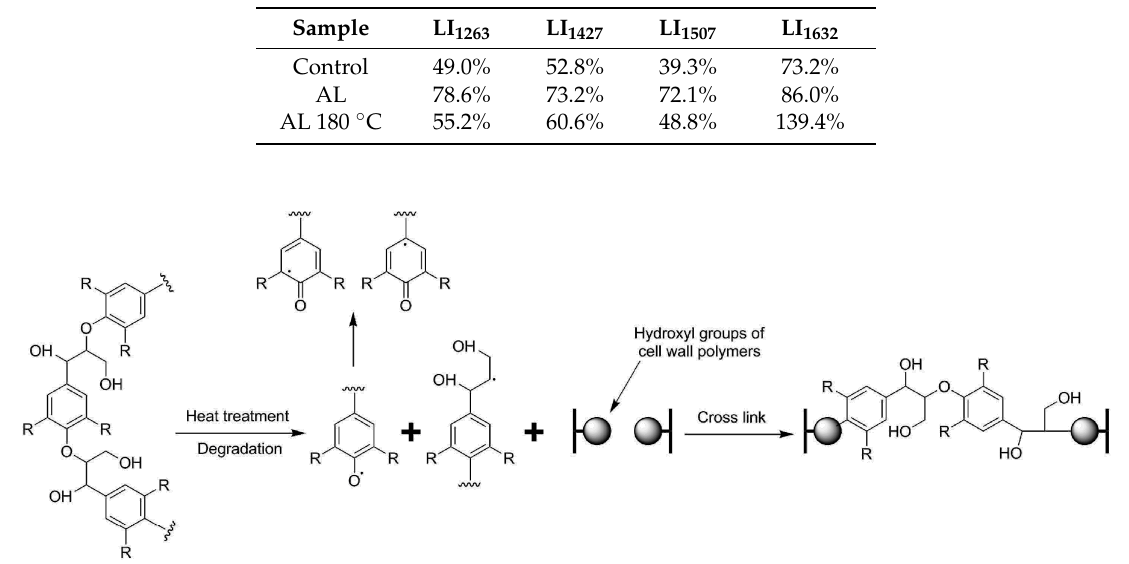
Figure 4. Schematic illustration and chemical reactions showing the bonding mechanism between lignin and the wood